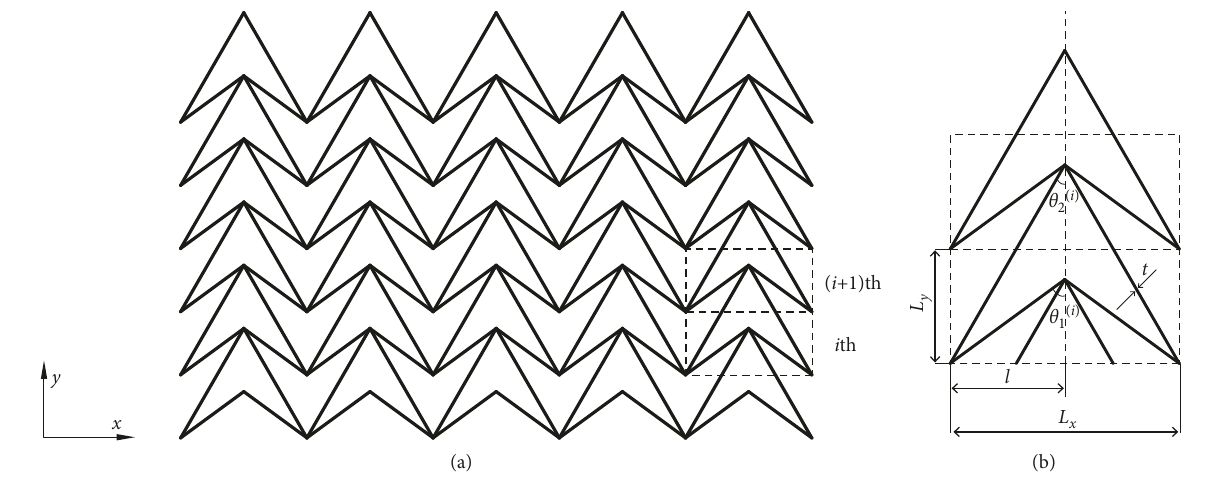
Figure 1: (a) Schematic diagrams of an array of auxetic DAHs and (b) a unit